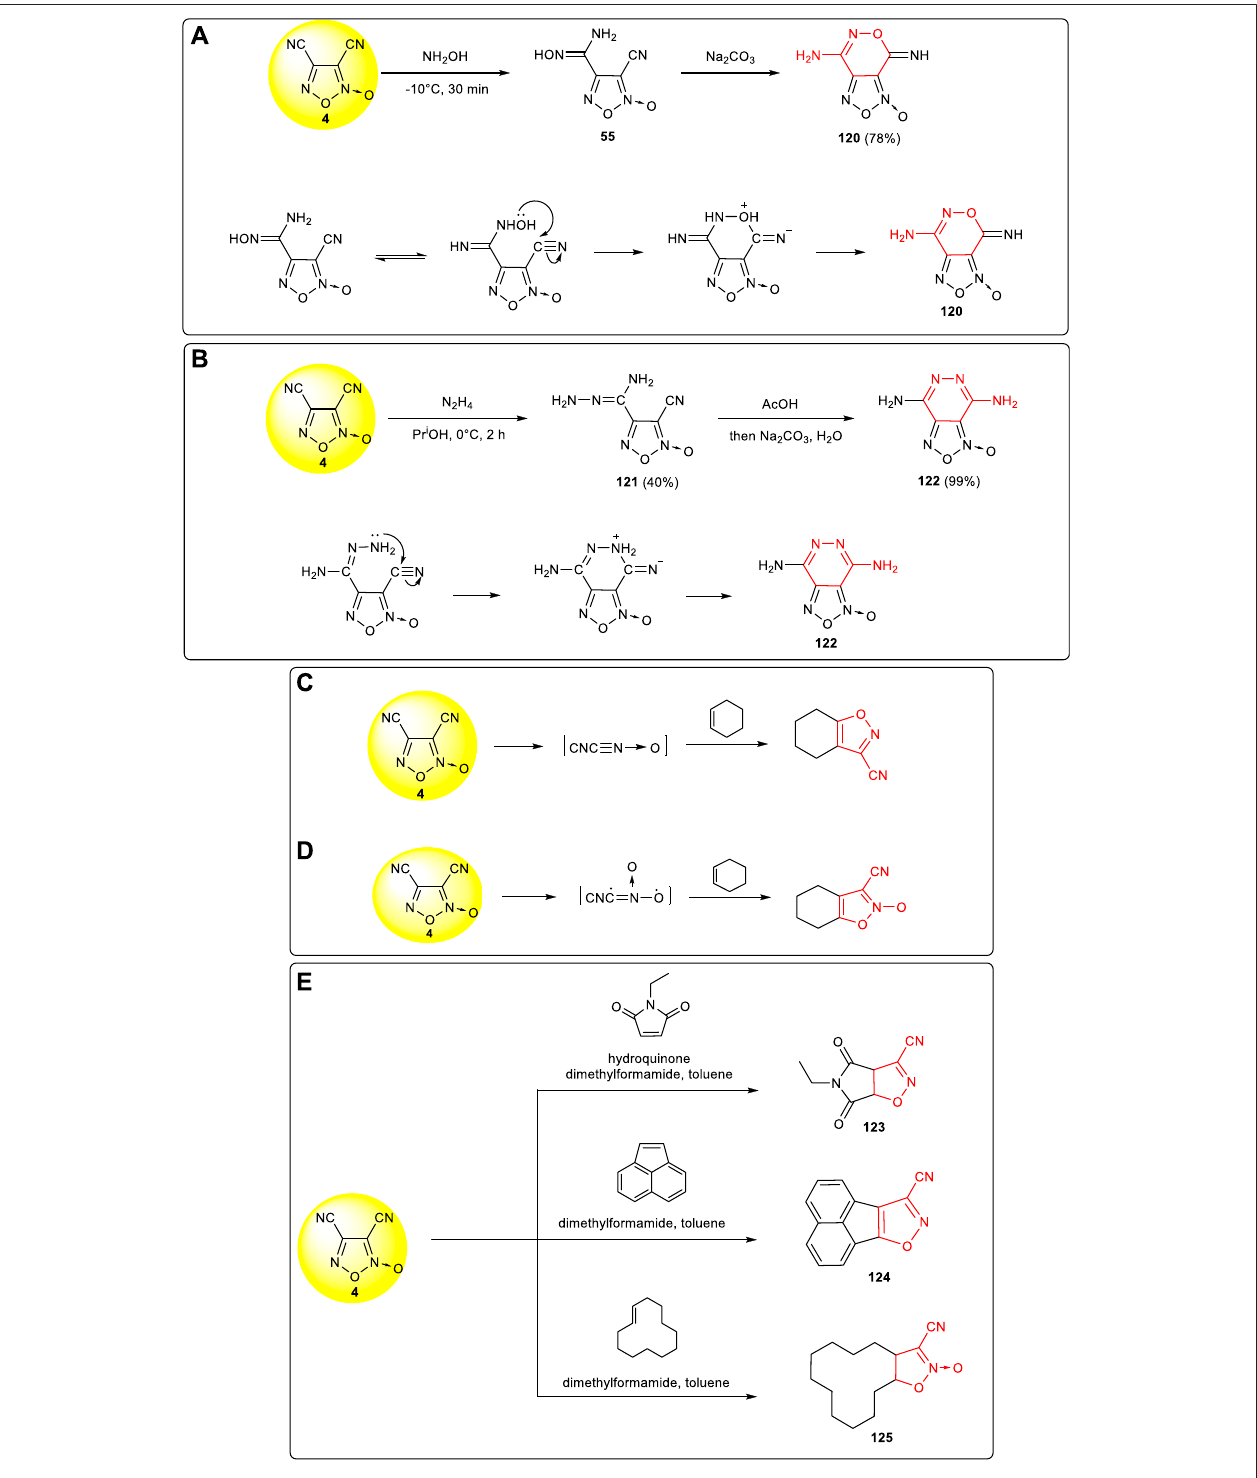
SCHEME 12 | (A) Synthesis of 120 and its cyclization mechanism; (B) synthesis of 122 and the cyclization mechanism of pyridazinofurazan; (C,D) two cyclization mechanism of fused ring structures; (E) three cyano-substituted fused ring structures.